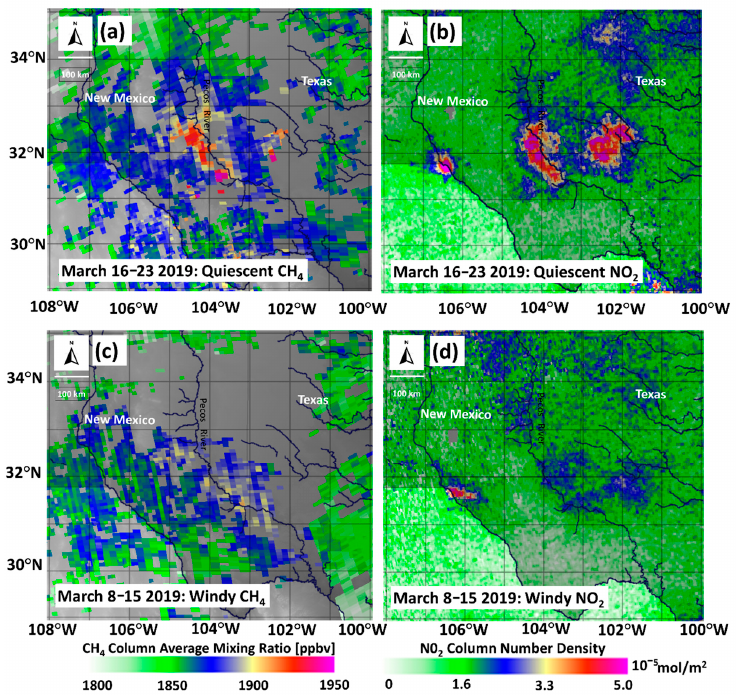
Figure 4. Average TROPOMI CH 4 column average mixing ratio (ppbv) for: ( a ) 16–23 March 2019 (quiescent); and ( c ) 8–15 March 2019 (windy). Average TROPOMI nitrogen dioxide tropospheric column number density (NO 2 , in mol/m 2 ) for: ( b ) 16–23 March 2019 (quiescent); and ( d ) 8–15 March 2019 (windy).